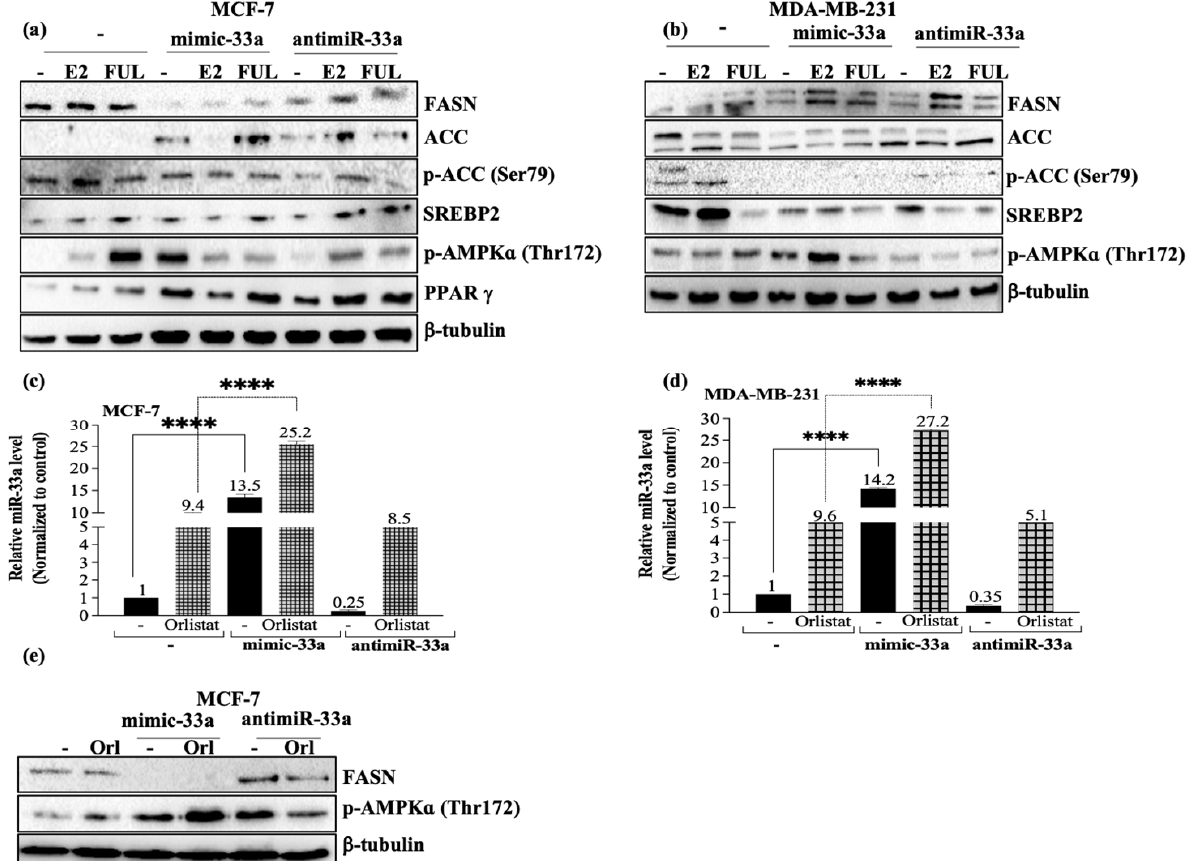
Figure 3. Investigation of the effect of miR-33a on fatty acid metabolism in MCF-7 and MDA-MB-231 cells. The function of miR-33a expression on fatty acid and energy metabolism in MCF-7 ( a ) and MDA-MB-231 cells ( b ) was determined by immunoblotting assay. β -tubulin was used as a loading control. The relative densitometry analysis was performed by two-way ANOVA Tukey’s multiple comparison test (**** p < 0.0001). The miR-33a expression was investigated by evaluating miR-33a in orlistat-treated MCF-7 ( c ) and MDA-MB-231 ( d ) cells. Columns represent the mean ± Std.dev of three independent experiments with two repeats (**** p < 0.0001 by two-way ANOVA, Tukey’s multiple comparison test). ( e ) FASN and p-AMPK α expression in miR-33a overexpressed/suppressed-orlistat-treated MCF-7 cells was investigated by immunoblotting assay. β -tubulin was used as a loading control. The relative densitometry analysis was performed by two-way ANOVA Tukey’s multiple comparison test (**** p < 0.0001). Uncropped Western Blot Figures are shown in Figure